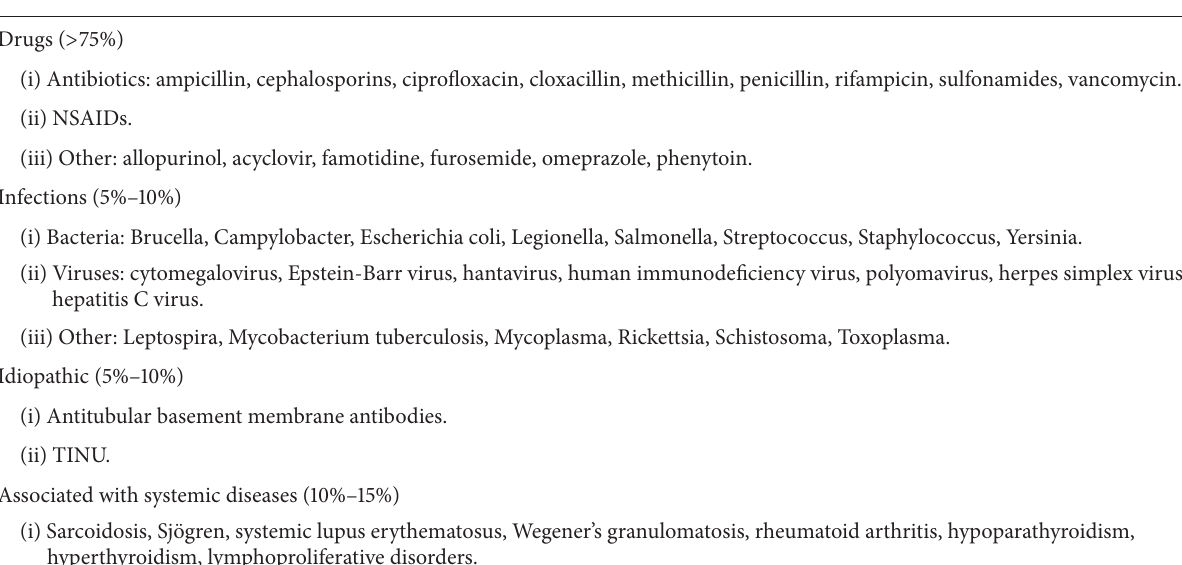
Table 1: Causes of acute tubulointerstitial